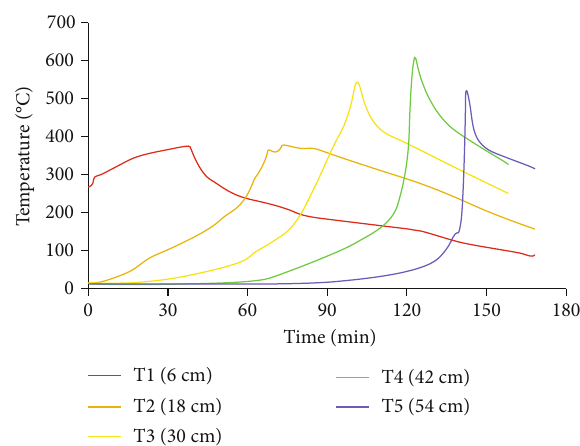
Figure 11: Temperature changes over time for di ff erent measurement points in 1D combustion tube test for D block.